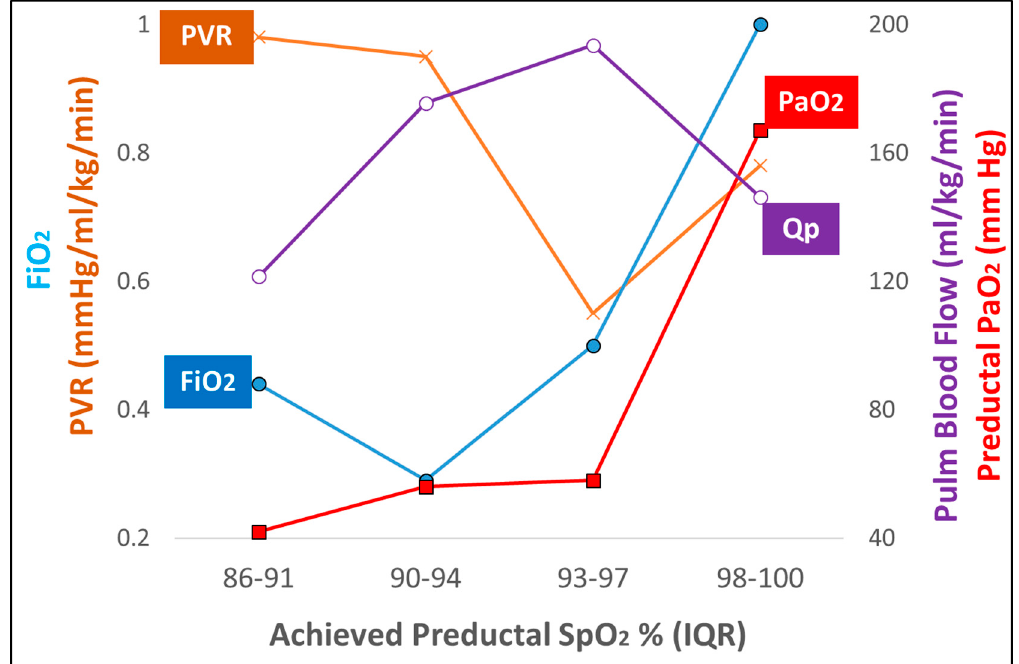
Figure 3. A graph depicting the relationship of inspired oxygen, PVR, left pulmonary blood flow, arterial oxygenation and preductal SpO 2 is illustrated in an ovine model of meconium aspiration model with PPHN. [36] The pulmonary vascular resistance (PVR—brown cross), pulmonary blood flow (Qp—purple open circles), FiO 2 (blue circles) and PaO 2 (red squares) at different preductal saturation (SpO 2 ) ranges are shown. Preductal SpO 2 in high 80 s resulted in high PVR and low Qp. Preductal SpO 2 in the low − 90 s was associated with increased PaO 2 , increased Qp, low FiO 2 and high PVR (due to high pulmonary arterial pressure–not shown). Preductal SpO 2 in the mid − 90 s was associated with FiO 2 in the 0.5 range with lowest PVR, highest Qp in this model. Increasing FiO 2 to 1.0 increased PaO 2 and SpO 2 but did not result in further increase in Qp or decrease in PVR. For detailed